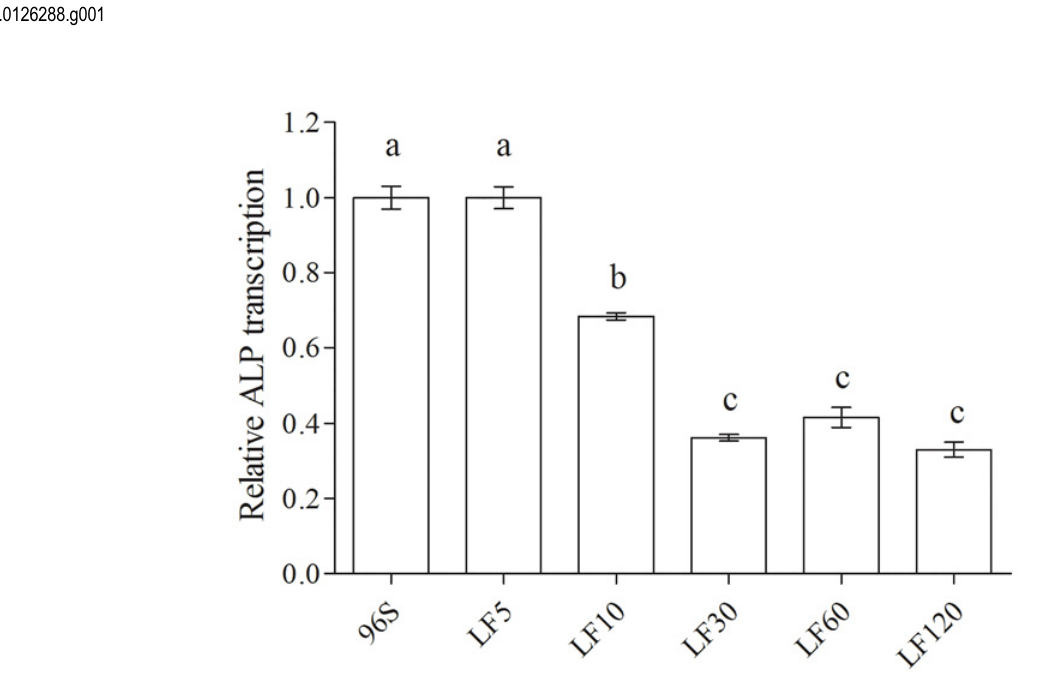
Fig 2. Relative ALP transcription detected by qRT-PCR in susceptible and resistant H . armigera larvae. Different letters above the error bars indicate significant differences between means (P < 0.05).